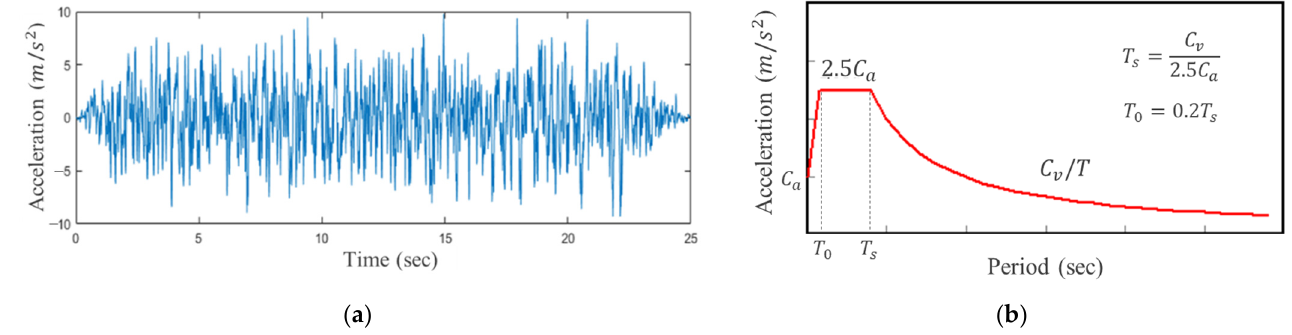
Figure 16. Formation of an artificial earthquake acceleration: ( a ) Artificial earthquake accelerogram; ( b ) Design response spectrum.